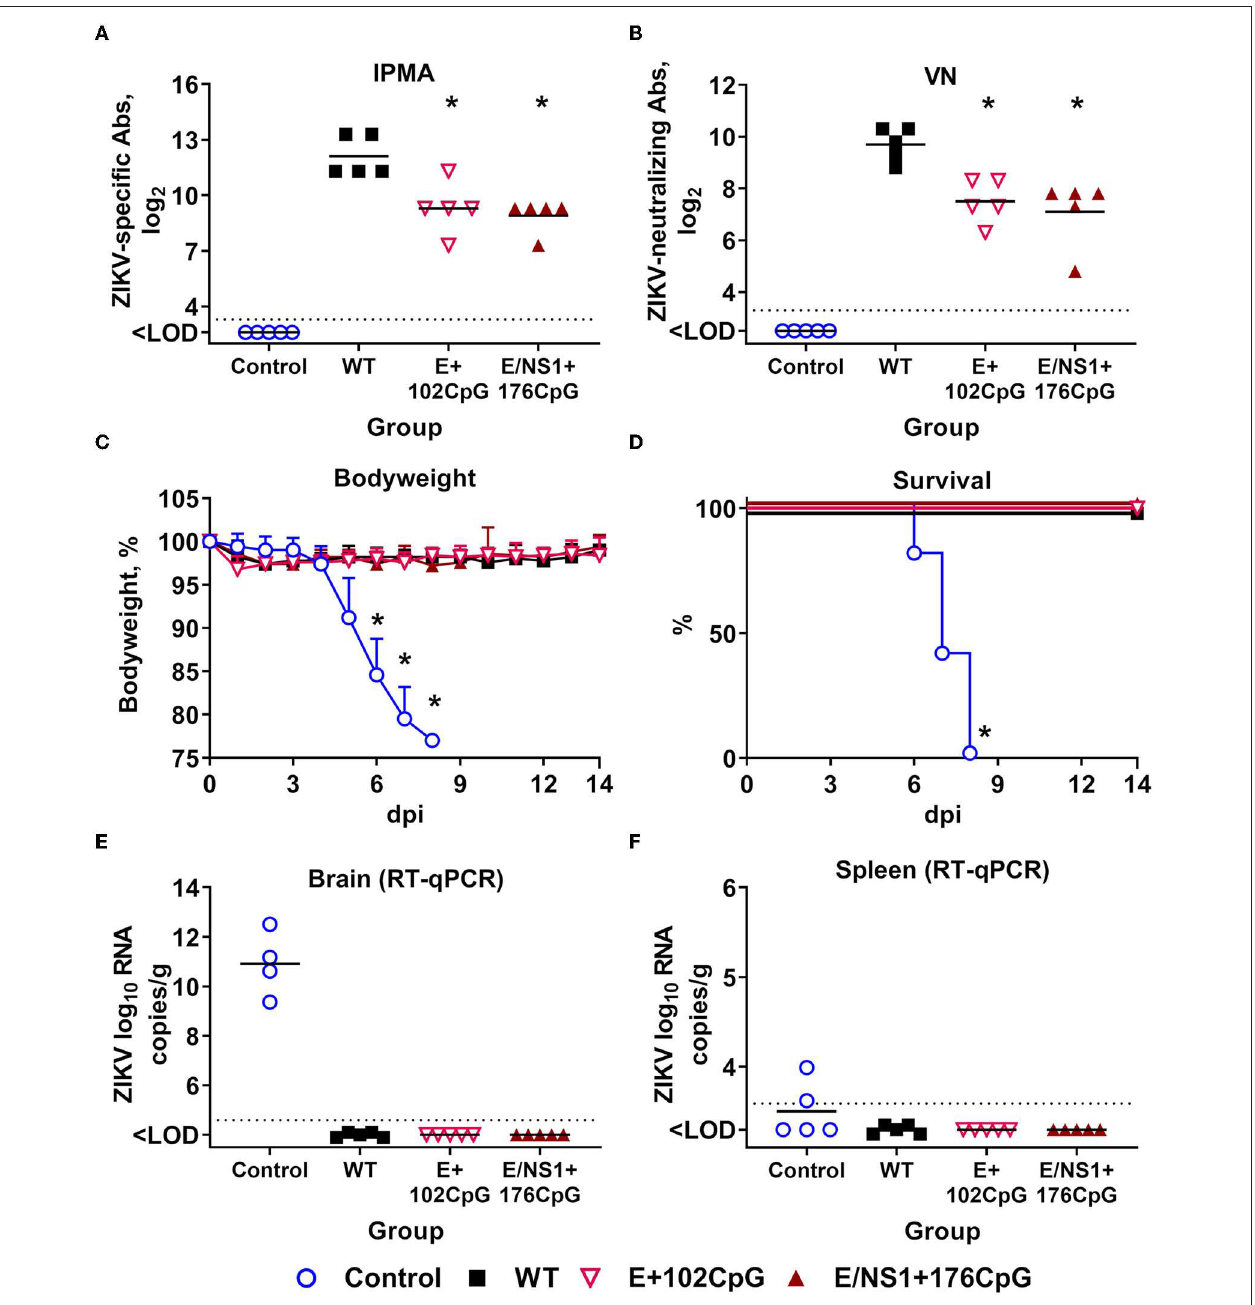
FIGURE 10 | Protective efficacy of WT and CpG-recoded ZIKV variants in adult mice. ZIKV-specific (A) and neutralizing (B) Abs at 28 days after immunization with 10 5 TCID 50 of WT or CpG-recoded ZIKV variants. IPMA, immunoperoxidase monolayer assay; VN, virus-neutralizing assay. Bodyweight (C ; bodyweight at day 0 was used as a baseline ) , survival (D) , and ZIKV loads in the brain (E) and spleen (F) after IC challenge with 10 5 TCID 50 of the heterologous mouse-adapted ZIKV MR-766 strain. Asterisk (*) denotes a statistically significant difference to the WT ZIKV group. Dotted lines represent the LOD (A,B,E,F) ; solid lines represent mean